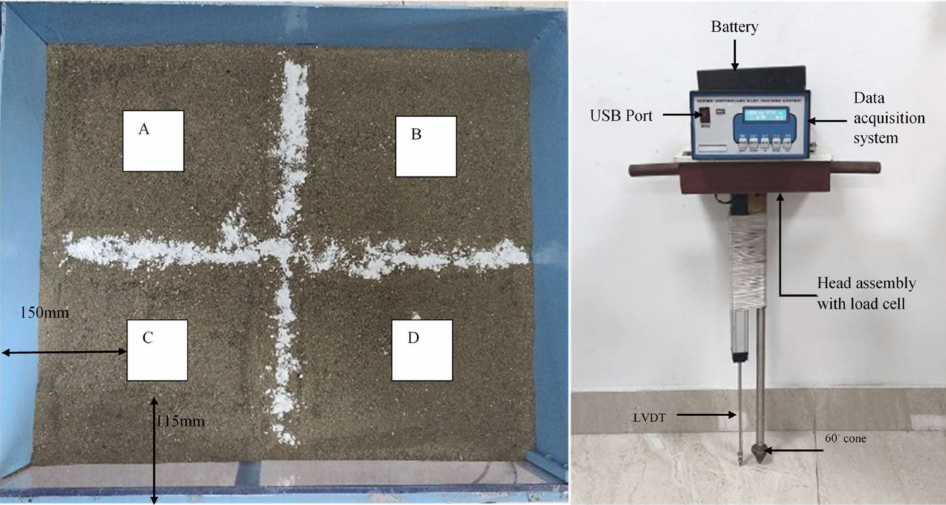
Figure 4. Layout of the test section measurement and testing locations A, B, C and D of digital SCP